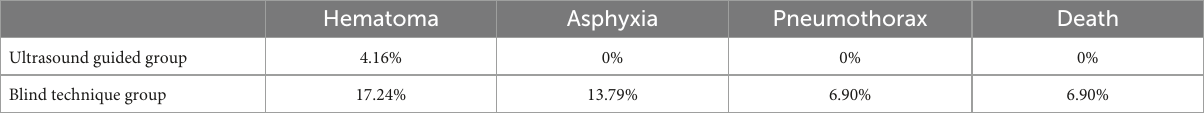
TABLE 2 The incidence of blood chest, dyspnea, pneumothorax and death in rats with stellate ganglion block under blind technique and ultrasound-guided group. Hematoma